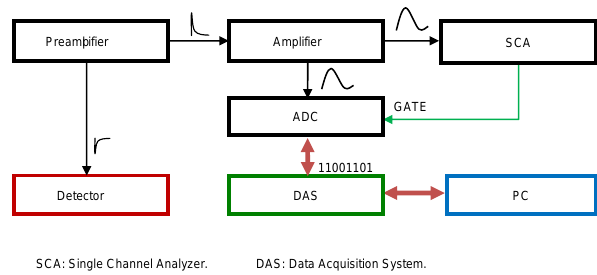
Figure 4. Data acquisition block diagram with NIM modules. ADC working in coincidence